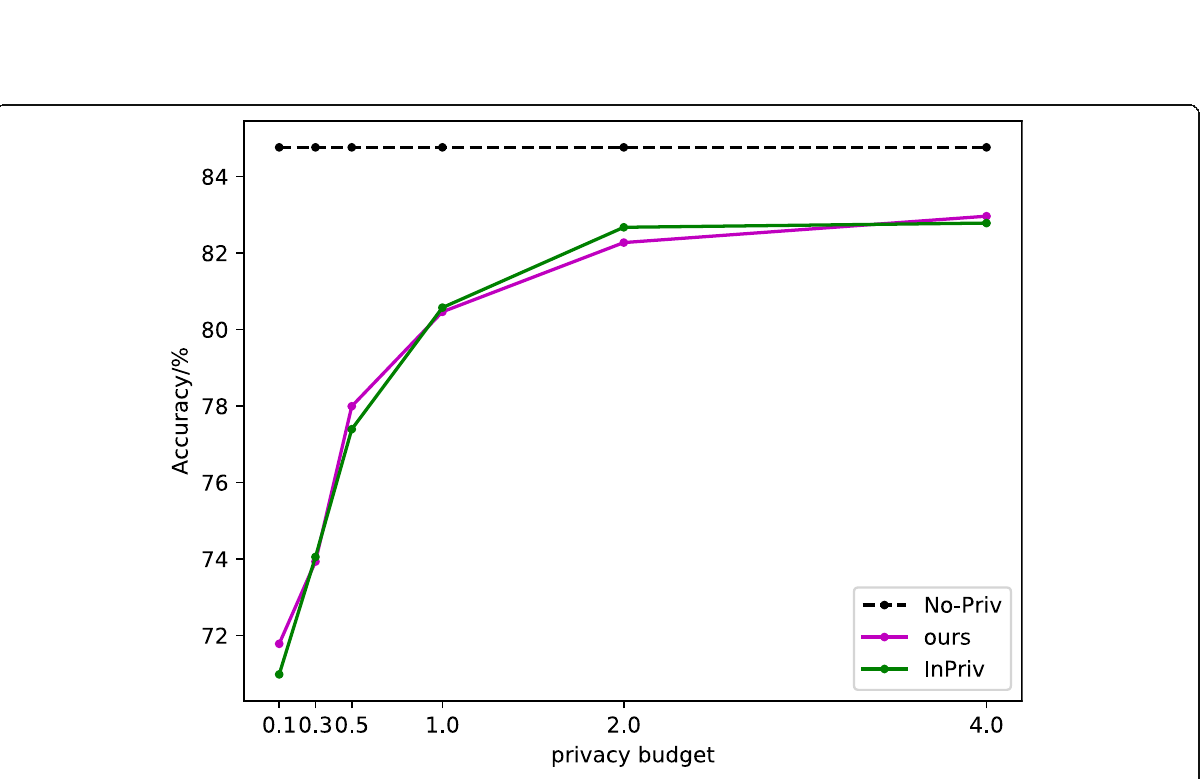
Fig. 5 The comparison of model performance on Adult